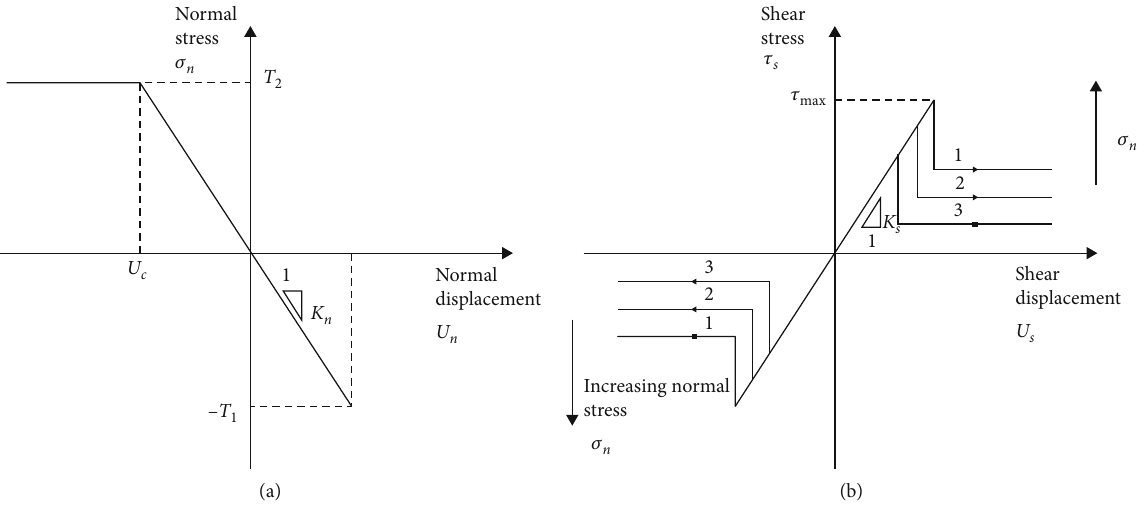
Figure 3: Monitoring data: (a) surface displacement; (b) displacement of slope at depth.